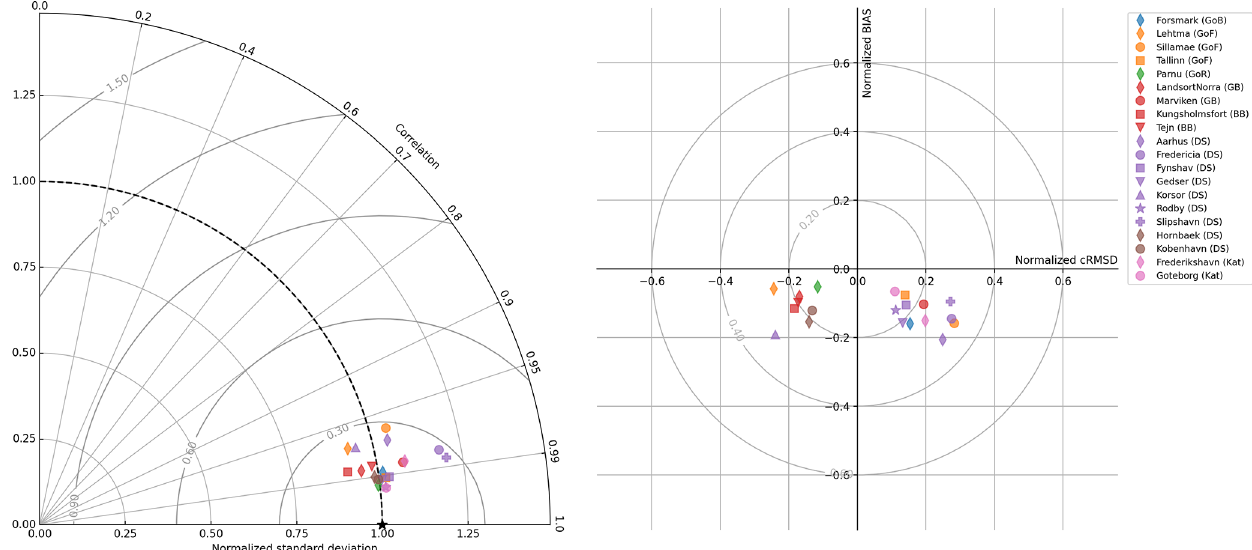
Figure 5. Taylor and target diagram of surface temperature error metrics. The metrics have been normalized by the standard deviation of the observations. See Fig. 1 for station locations; the sub-basin abbreviations are as in Fig.